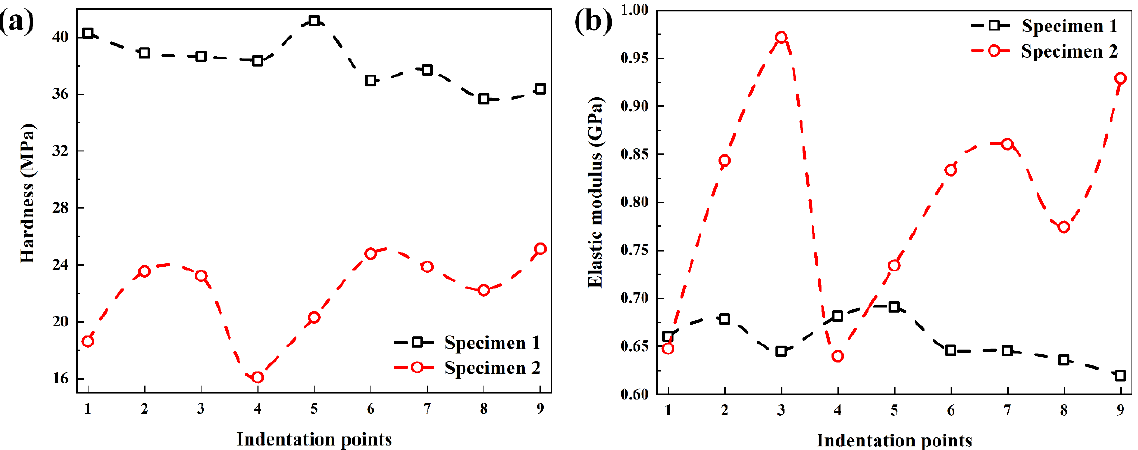
Figure 6. Mechanical parameters of specimens based on the Oliver–Pharr method: ( a ) hardness; ( b ) elastic modulus.